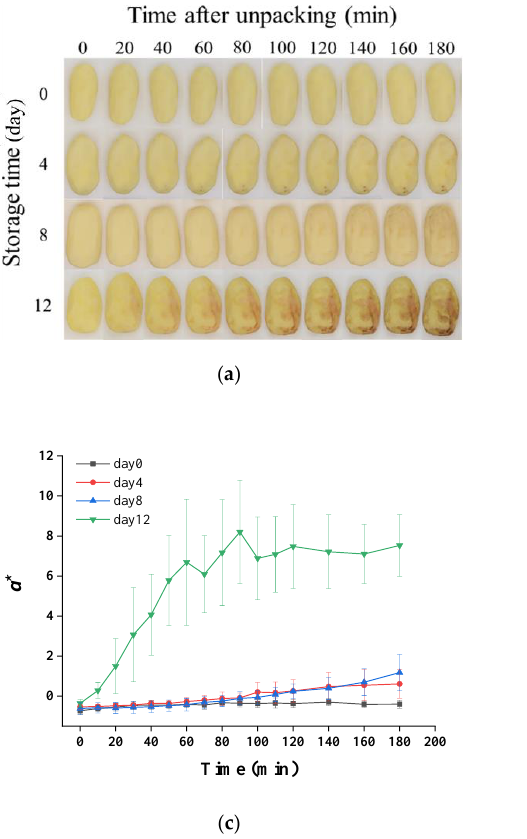
Table 1. The surface discoloration of the 0-, 4-, 8- and 12-day samples started at about 31.88, 35.50, 20.35 and 5.71 min, respectively. A delay of browning on day 4 was observed compared to day 0, which could have been due to the inhibition of phenylalanine ammo- nia lyase activity by the increase of organic acid [38]. The discoloration of day 12 samples happened significantly earlier than other samples, which was also found in the results of the color change measured by the colorimeter (Figure 4b – d). Lightness ( L * ), reddish – greenish ( a * ) and yellowish – bluish ( b * ) values also suggested a browning process of pota- toes after opening the package. The samples of day 12 showed an obviously different trend compared to others. As presented in Figure 4b,d, a continual decrease was observed in the L * and b * values. In terms of a * values, day 12 showed an increasing trend firstly, and